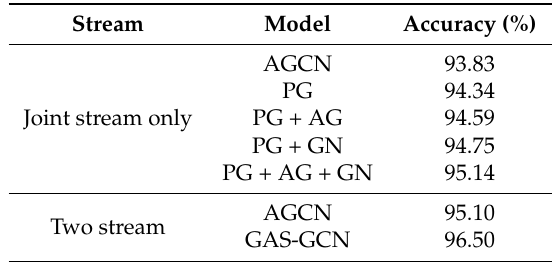
Table 3. The importance of ASGCM (AG) and gated CNN (GN) were evaluated on NTU-RGB + D